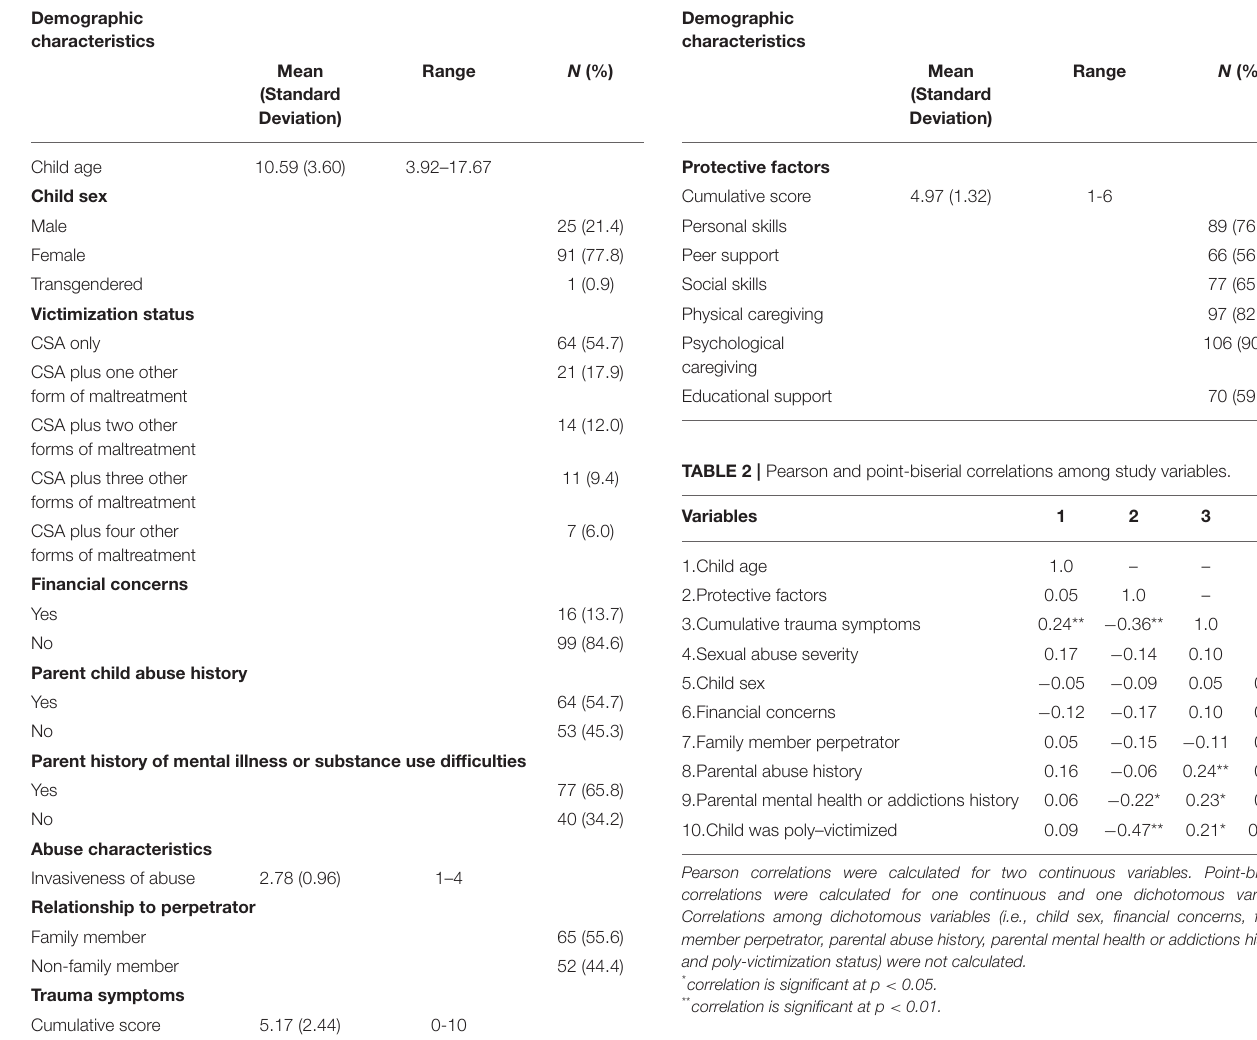
TABLE 1 | Descriptive characteristics of the total sample ( n = 117).